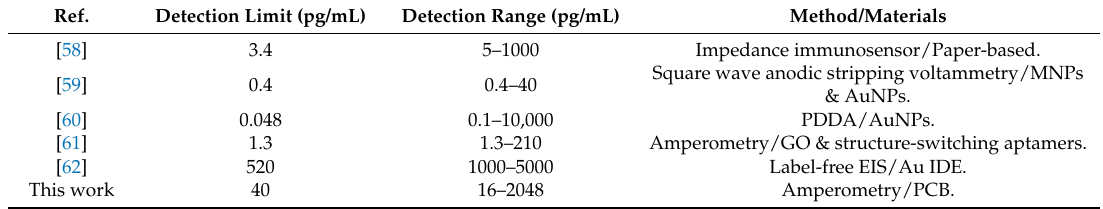
Table 3. Indicative, state-of-the-art IFN γ -detection systems, utilising different methods and materials.